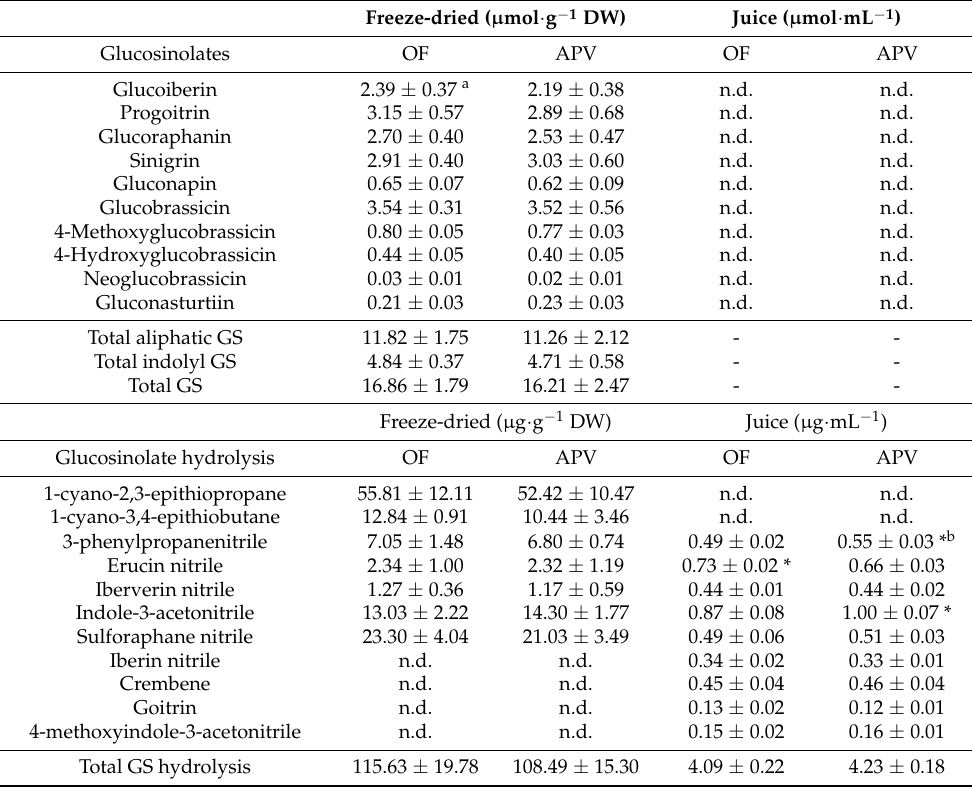
Table 2. Glucosinolates and their hydrolysis products in cabbages from open-field and agriphoto- voltaic